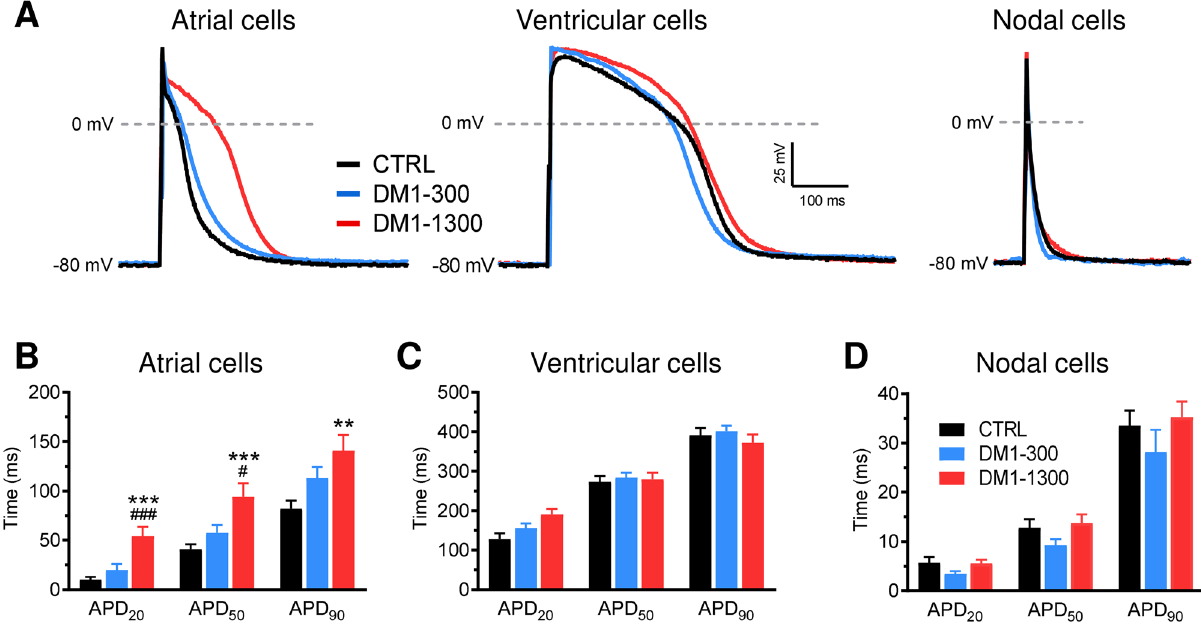
Figure 5. APD prolongation revealed by patient-specific iPSC-CMs. ( A ) Representative AP traces of atrial, ventricular, and nodal-like cells recorded in CTRL, DM1-300, and DM1-1300 iPSC-CMs. ( B ) Bar graph summarizing the APD at 20%, 50%, or 90% of repolarization in atrial-like (n = 19–21), ( C ) ventricular-like (n = 12–25), and ( D ) nodal like (n = 14–21) cells at a stimulation frequency of 1 Hz. Bars indicate SEM. **p < 0.01, ***p < 0.001 (CTRL vs DM1-1300) and # p < 0.05, ### p < 0.001 (DM1-300 vs DM1-1300) as determined by ANOVA and Turkey’s post hoc